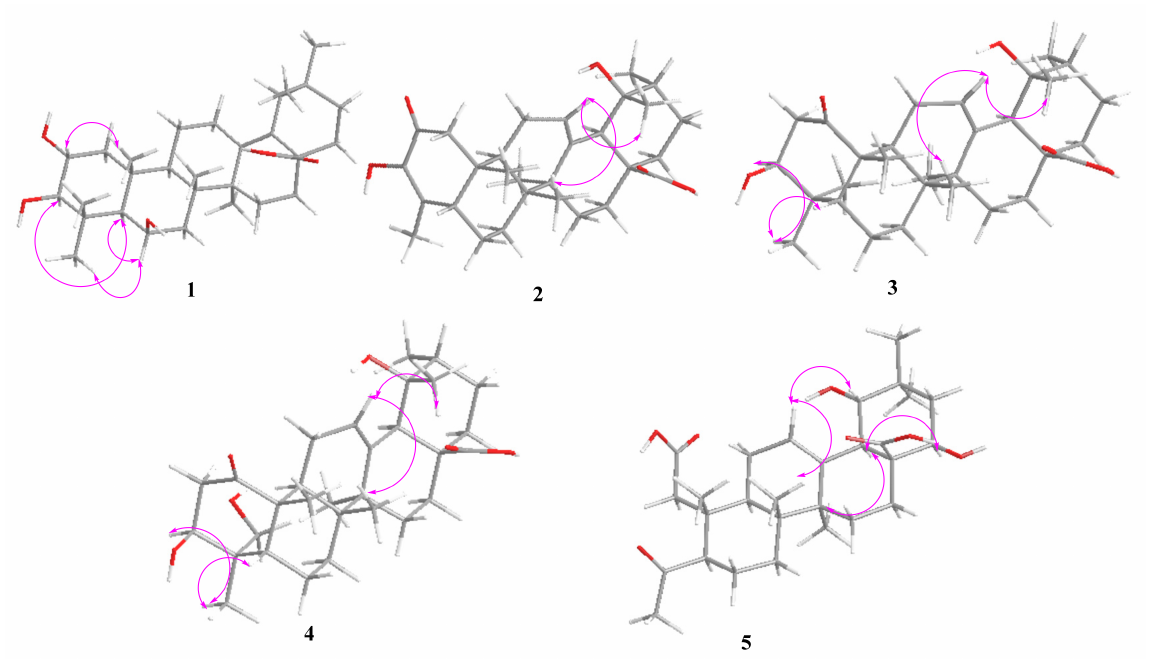
Figure 3. Key NOESY correlations of compounds 1 – 5